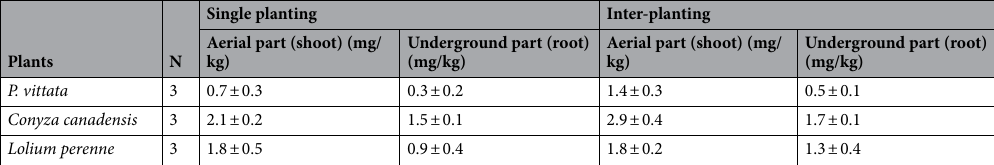
Table 1. Mean values for biomasses of aerial part and underground part of single plant and interplant garlic with P. vittata, Conyza canadensis and Lolium perenne . N number of plants sampled.